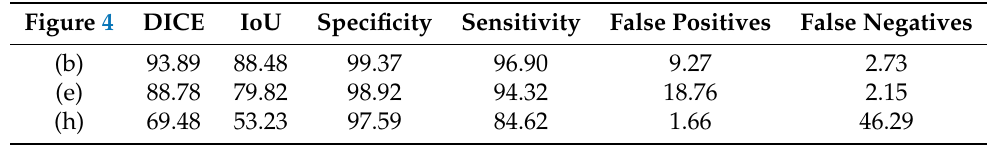
Table 5. Overlap measures between the model associated with the left foot and the corresponding segmentation simulating an amputation as shown in Figure 4. Values are expressed as